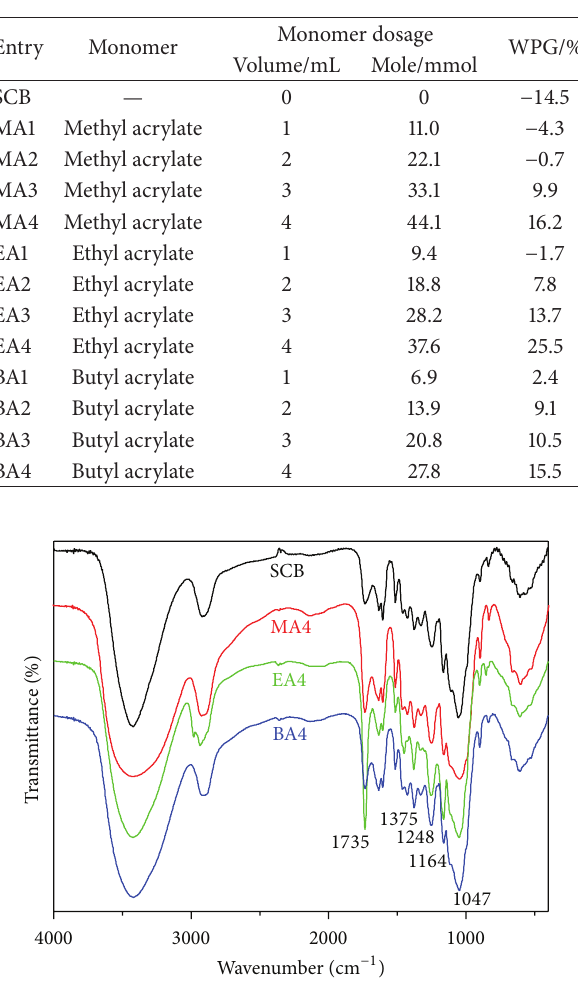
Table 1: Preparation of sugarcane bagasse graft copolymers.